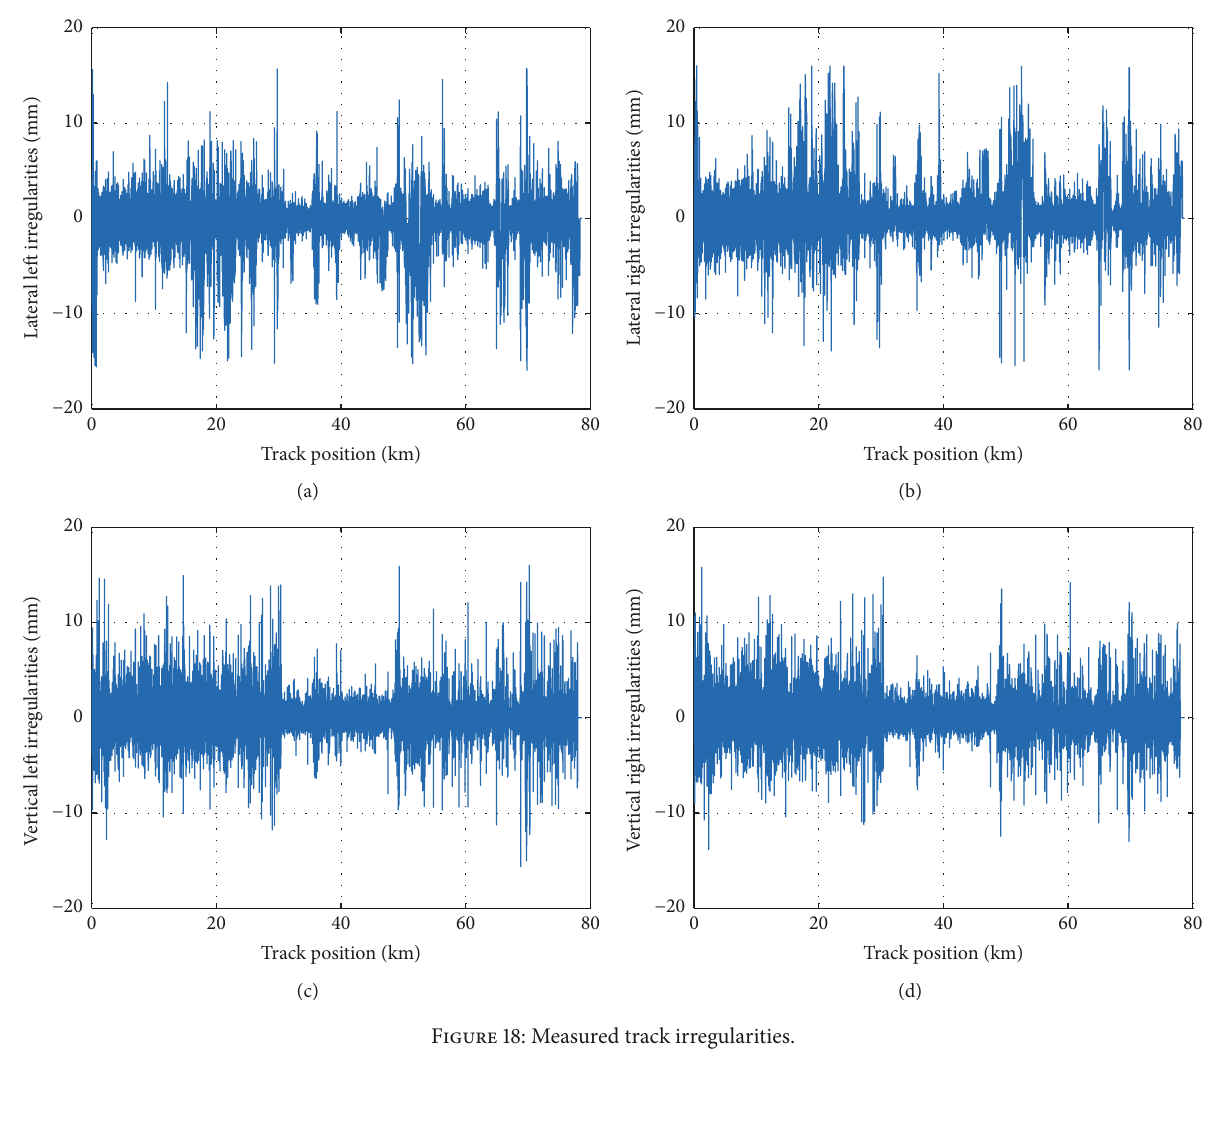
Figure 18: Measured track irregularities.